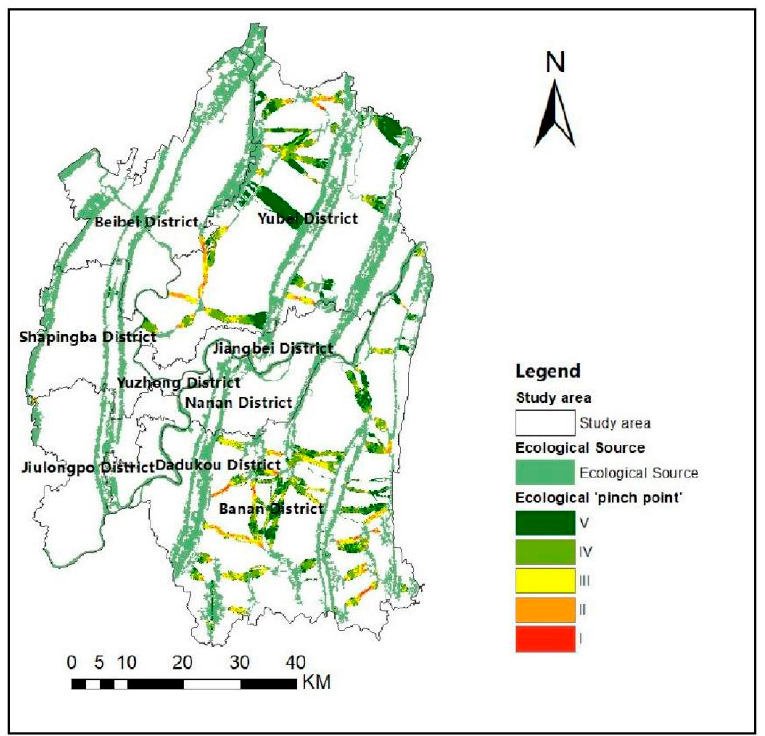
Figure 10. Ecological “pinch point” classification.